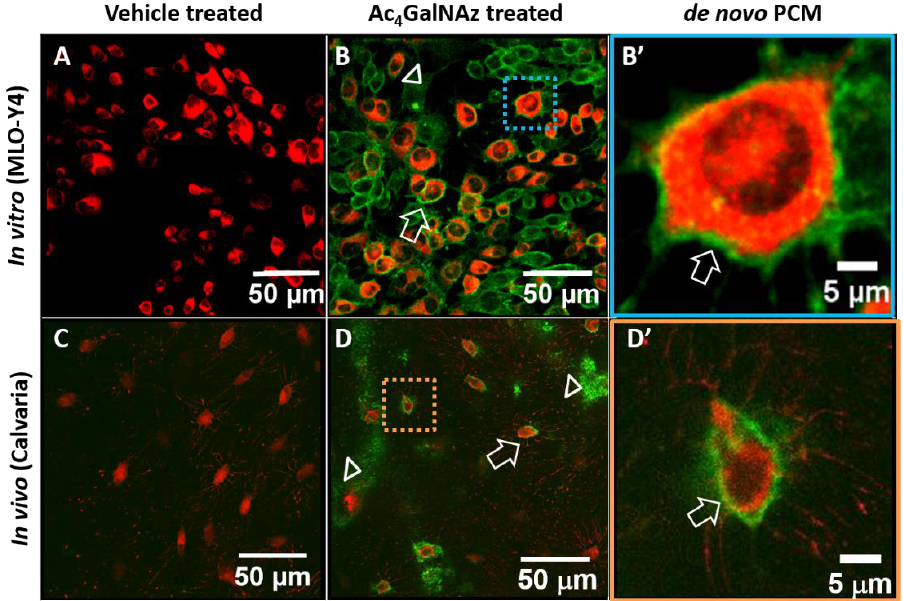
Figure 2. Metabolic labeling of de novo osteocytic PCM in vitro ( A , B , B’ ) and in vivo ( C , D , D’ ). While the vehicle treated cells ( A ) and animal tissues ( C ) showed negligible green signal, green “halos” (arrows) were observed around MLO-Y4 cells (stained in CellTracker TM Red, B ) and osteocytes in calvaria of mT/mG mice (red, D ). Green signals (arrow heads) also were observed at regions close to the bone surfaces ( D ). The labeled PCM (arrows) was clearly observed next to the plasma membrane, as shown in magnified views ( B’ , D’ ).